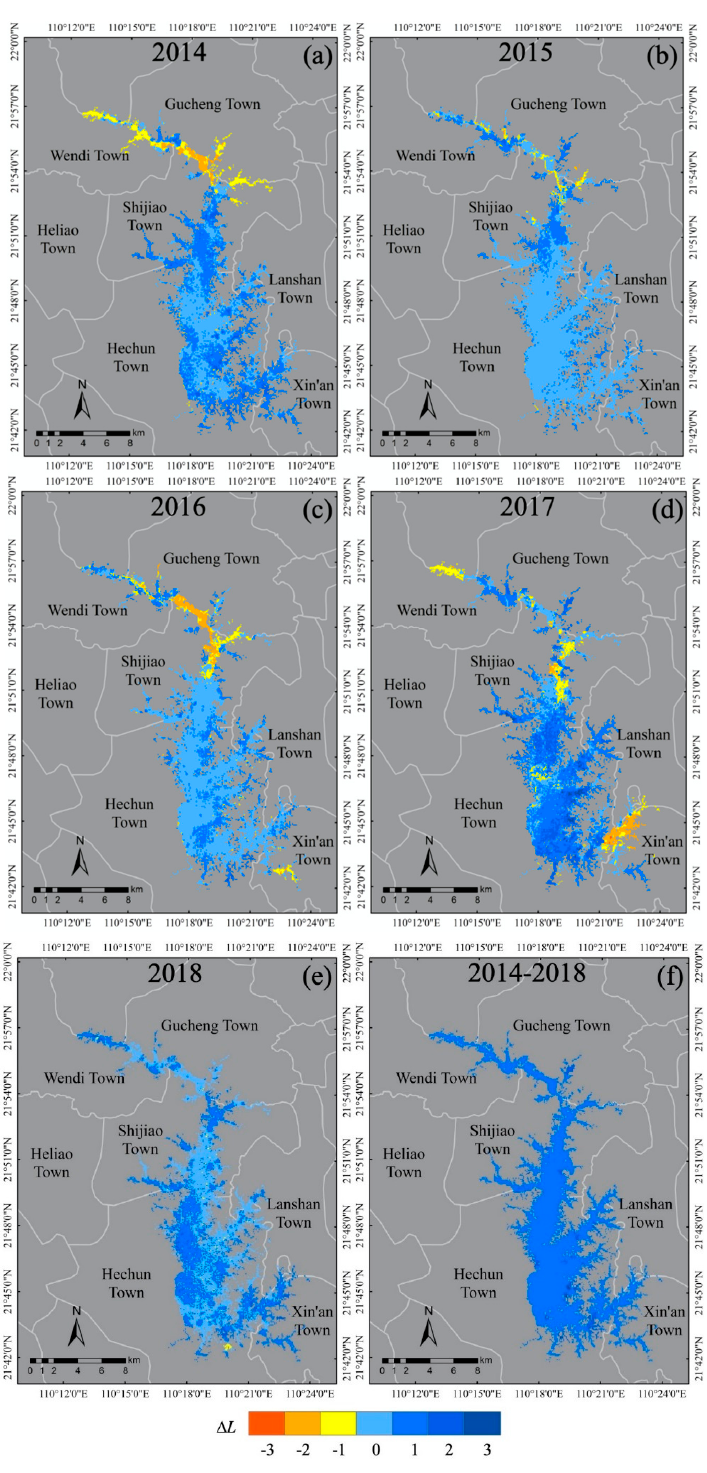
Figure 12. The spatial distribution map of water quality variation calculated by the progress degree combining the Markov model and the remote sensing method from 2014 to 2018 in Hedi Reservoir, where ( a – e ) show the annual spatial variation distribution based on the progress degree and ( f ) presents the spatial variation within the whole five years. The color scale marked as ∆ L indicates the di ff erence in the number of changes in the two TSS levels during the change in the TSS level status. It means that the TSS level has increased and the water quality has improved when ∆ L is greater than 0, otherwise the TSS level has decreased and the water quality has deteriorated. Especially, ∆ L is 0, which means that the TSS level has not changed and the water quality remains stable.